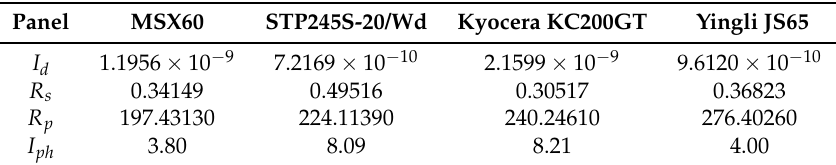
Table 3. Parameters of the mathematical model I d , R s , R p , and I ph for each PV